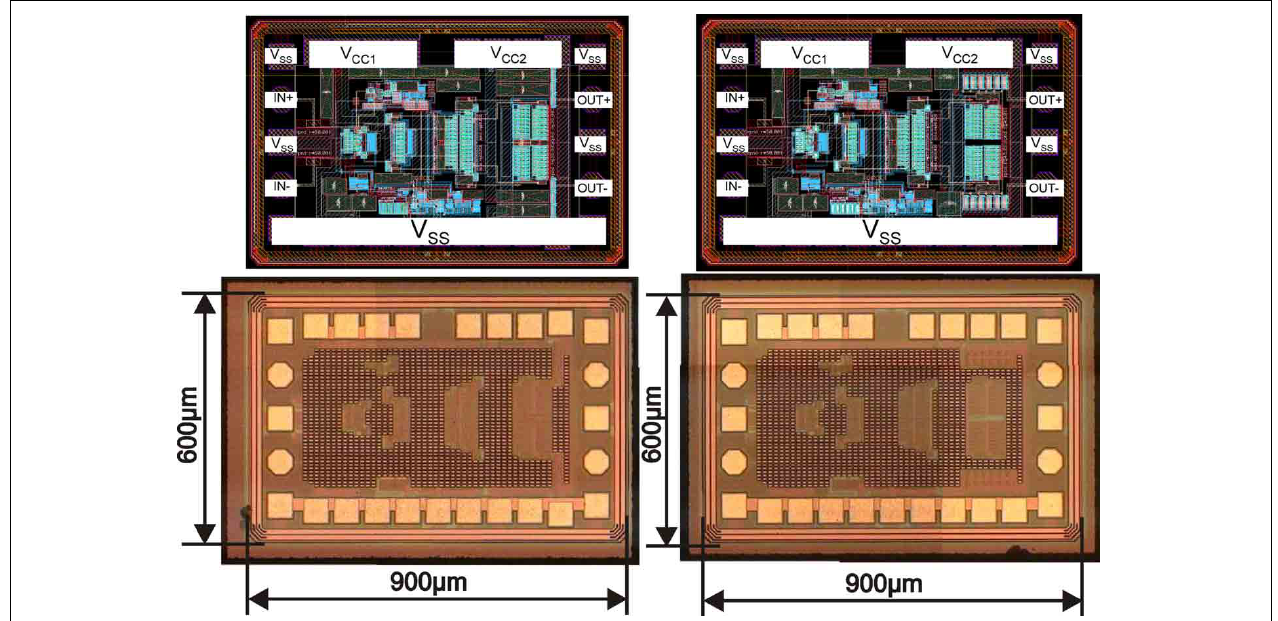
FIGURE 6 | Layout plots (top) and chip photos (bottom) of the realized test chips of both driver variants. The pictures on the left side correspond to driver variant one and that on the right side correspond to driver variant